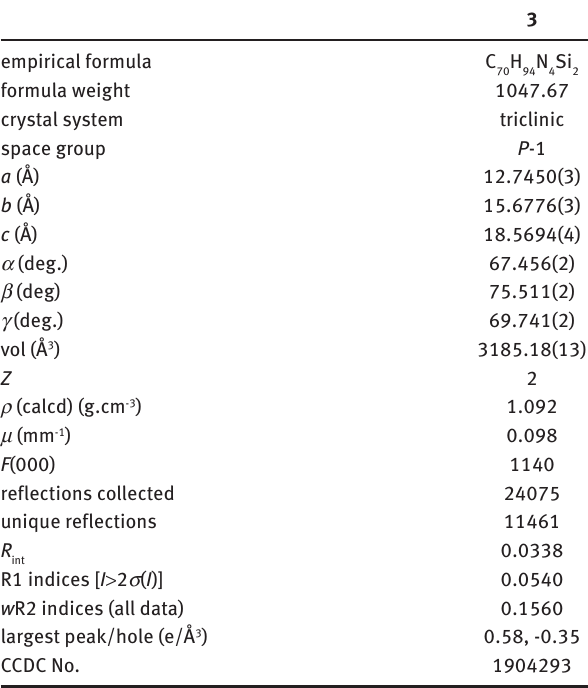
Table 1: Summary of crystallographic data for 3 .